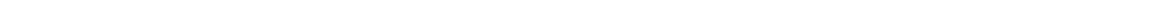
Fig. 4. Psammosteus livonicus Obruchev, positions of detail photographs on the branchial plates and ridge scales in Figs 6 and 7. A , B , PIN 220/527, left branchial plate; C , D , PIN 1737/7, holotype, right branchial plate; E , F , PIN 1737/74, right branchial plate; G , H , GIT 116-275, left branchial plate; I , J , GIT 116-272, left branchial plate; K , L , PIN 1737/8, left branchial plate; M , N , GIT 116-273, right branchial plate; O , P , PIN 1737/9, ventral ridge scale; Q , R , PIN 1737/76, dorsal ridge scale. Abbreviations: arrow indicates the anterior direction; a.p.l., anterior proximal ledge; s.tes, secondary tesserae; 1, contour line of the plate; 2, margin of ornamented surface; 3, growth line; 4, supposed growth line; 5, ornamented surface; 6, unornamented surface; 7, destroyed parts of the plate; 8, photograph of